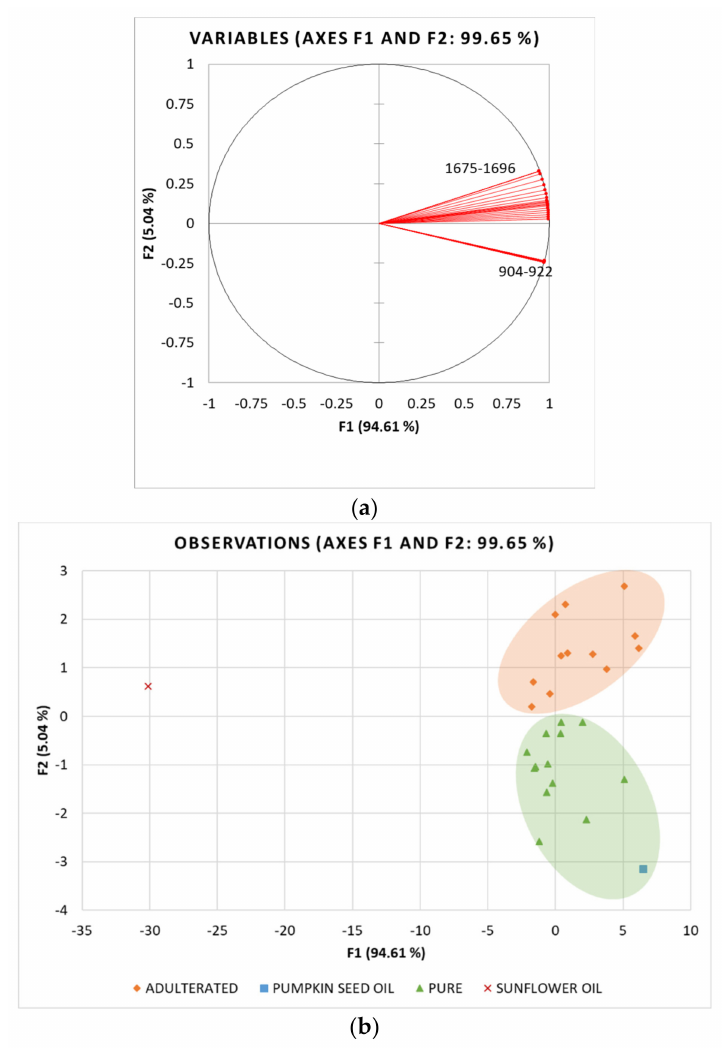
Figure 4. Principal component analysis (PCA) of NIR spectroscopy data: Projection of ( a ) active variables and ( b ) oil samples (SO_1–25—commercial oils labelled as pumpkin seed oil, laboratory pumpkin seed oil and refined sunflower oil) on the factorial plane (F1 × F2). For the NIR results, a total of 44 variables (wavelengths) and 27 cases (samples) were included in the PCA analysis. The PCA run yielded two principal components, i.e.,